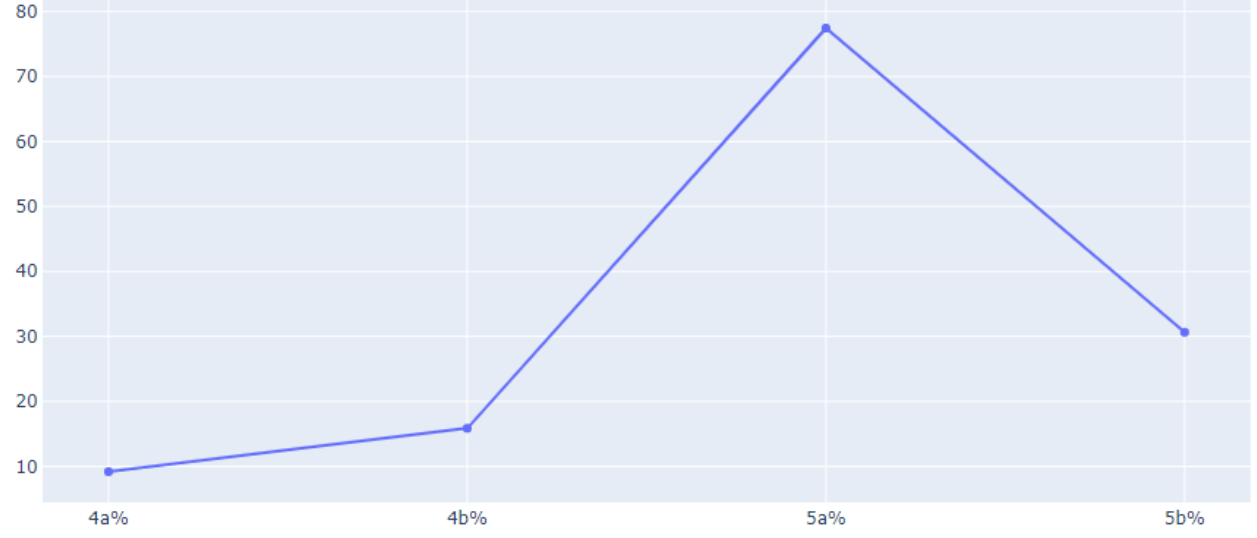
Figure 6. The percentage of questions 4A, 4B, 5A, and 5B before and after the COVID-19 pandemic. According to the LTC institutions, every resident used to take part in the recreational and socializing activities, but due to the COVID-19 pandemical appearance, with a min- imum distance of one or two meters between them, the activities had to be adapted to